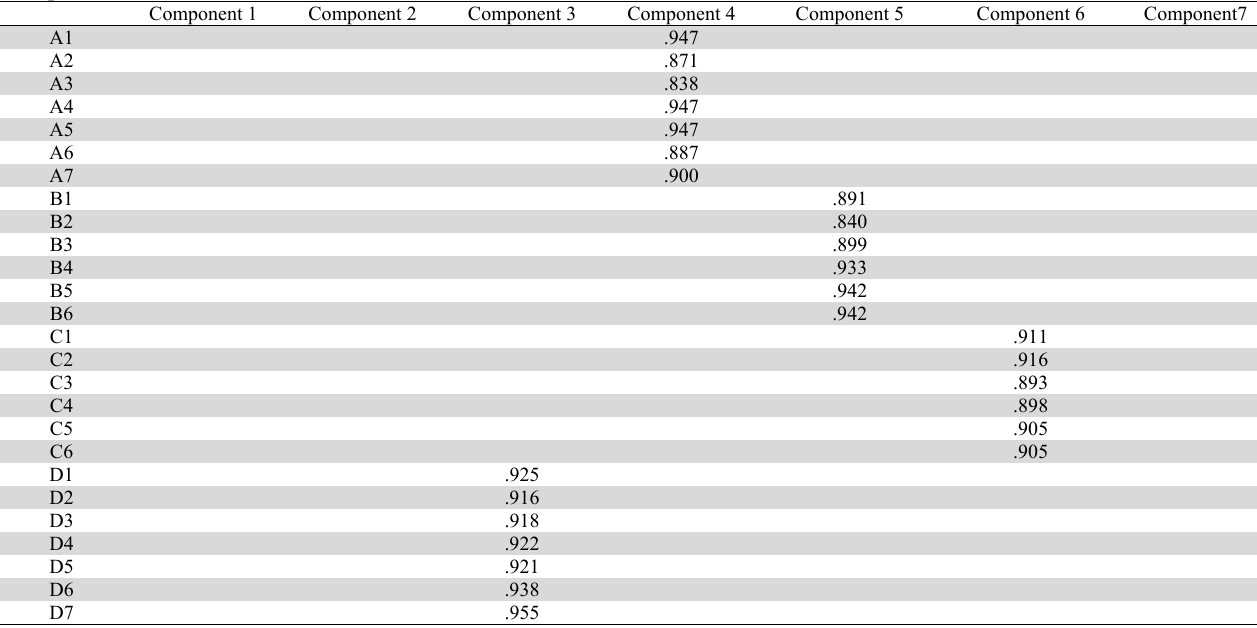
Component rotation